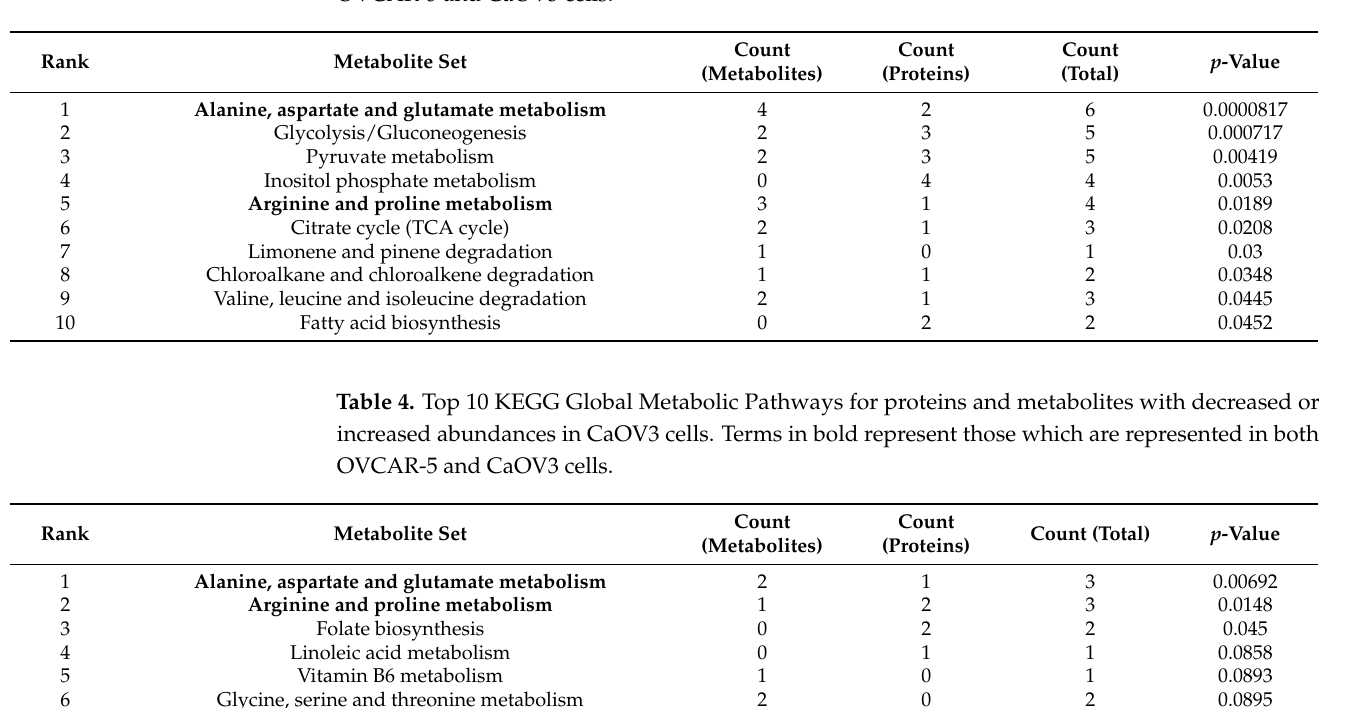
Table 3. Top 10 KEGG Global Metabolic Pathways for proteins and metabolites with decreased or increased abundances in OVCAR-5 cells. Terms in bold represent those which are represented in both OVCAR-5 and CaOV3 cells.